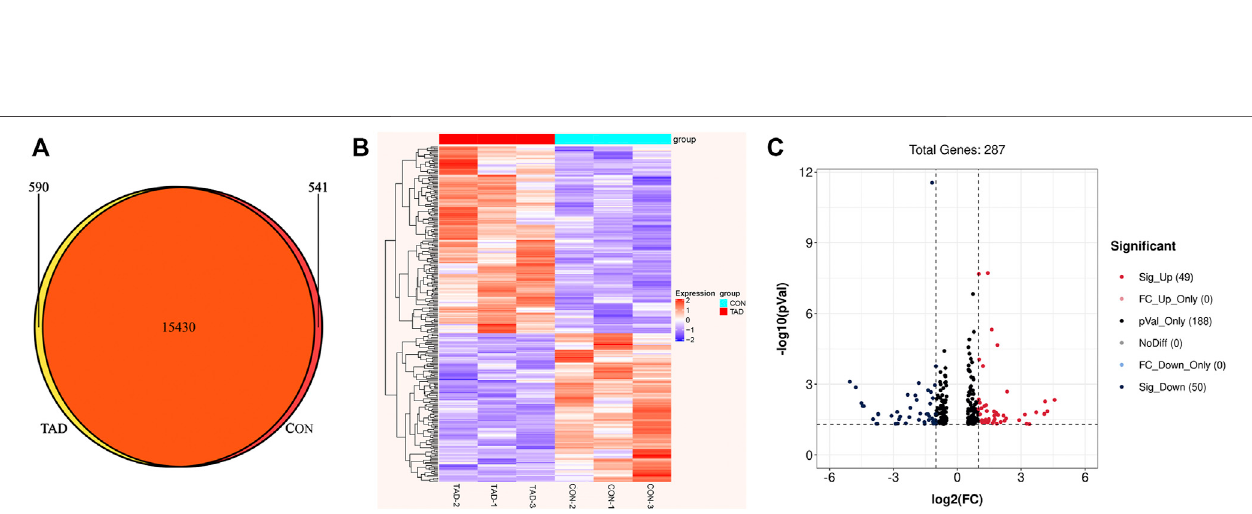
FIGURE 2 | Transcriptional differences between colorectal cancer HCT116 cells treated with tadala fi l (TAD) and without tadala fi l (CON). (A) Venn diagram of transcriptome pro fi les in TAD and CON groups. Gene expression analysis revealed that 15,430 genes were co-expressed in TAD and CON groups, while 590 and 541 genes were speci fi cally expressed in TAD and CON groups, respectively. (B) Cluster heatmap of differentially expressed genes (DEGs) induced by tadala fi l in HCT116 cells; the green to red color scale indicates the value of log2 (FPKM) after scale number. (C) Volcano plot of DEGs; the green indicates downregulated DEGs, and red indicates upregulated DEGs. p -value < 0.05 and FC ≥